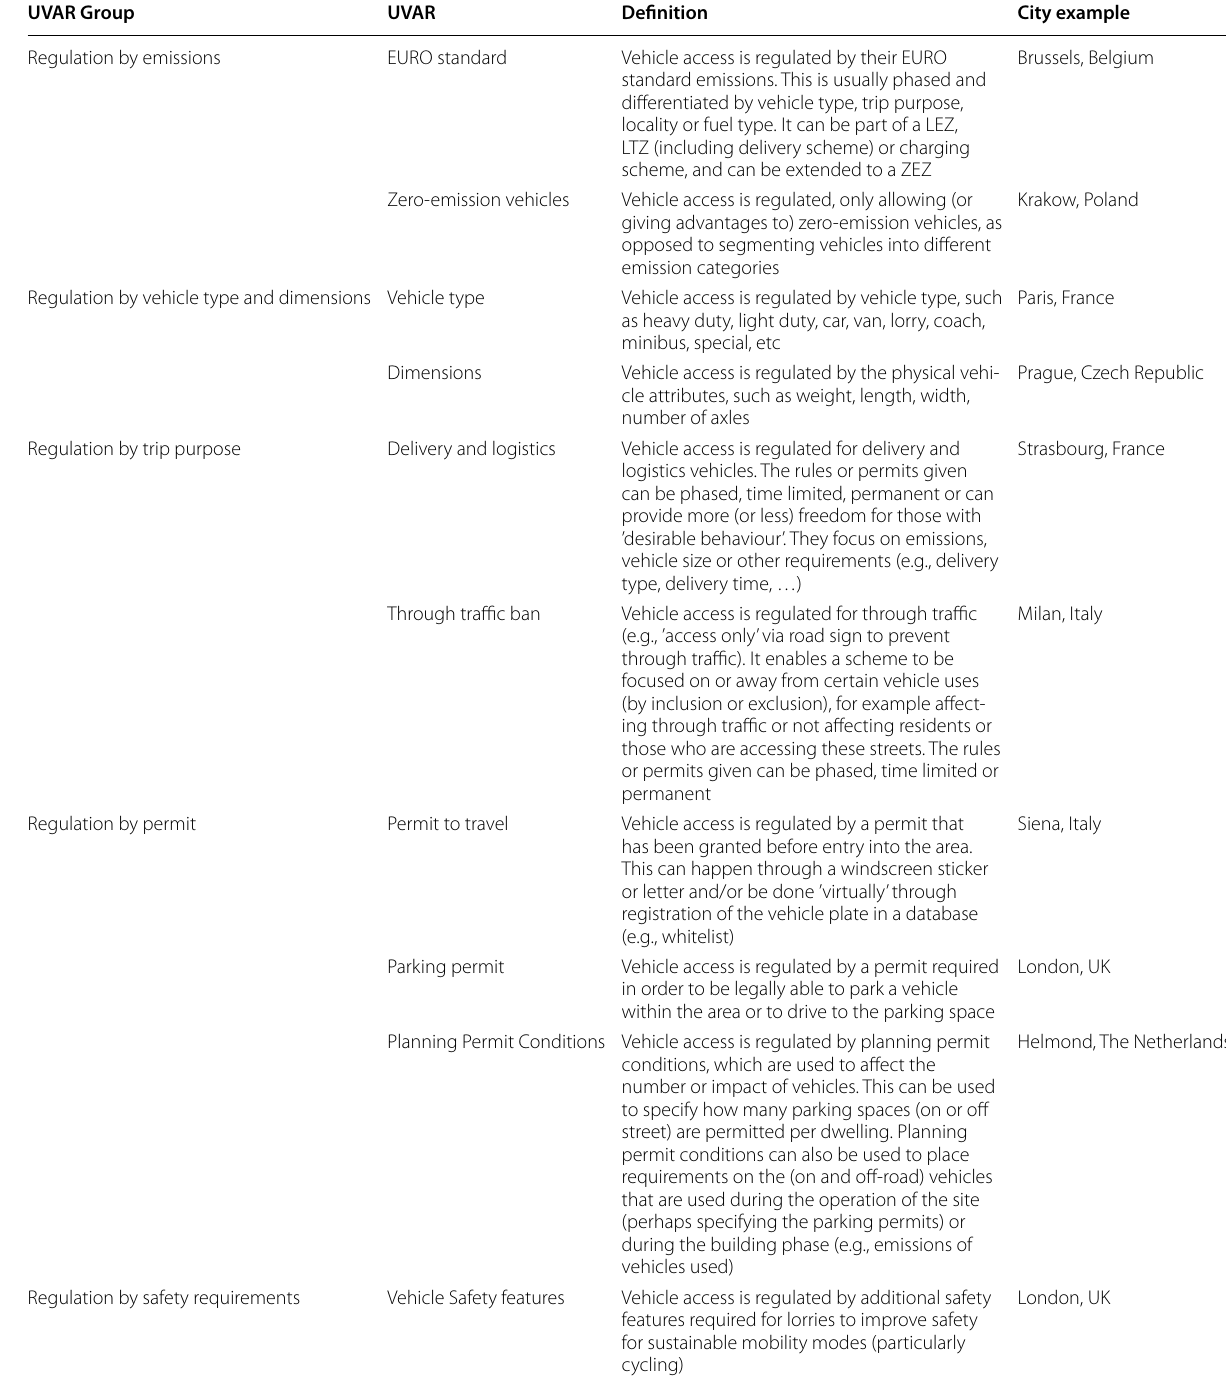
Table 4 UVAR for the regulatory measures category, showing the overarching group, definition and a city example where the measure is